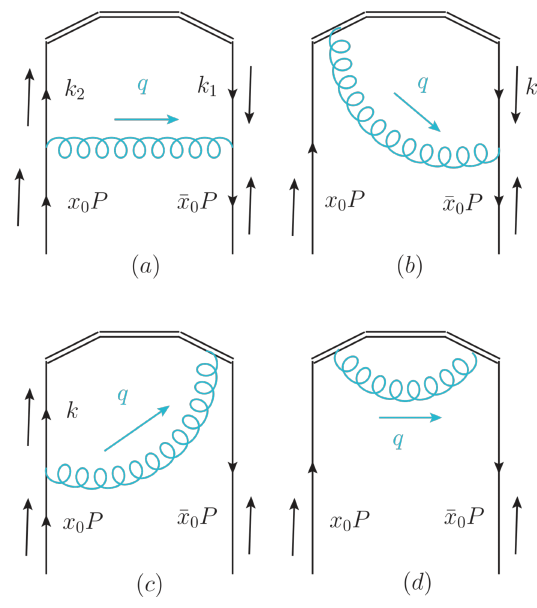
Figure 9 . One-loop diagrams for the quasi TMDWF.